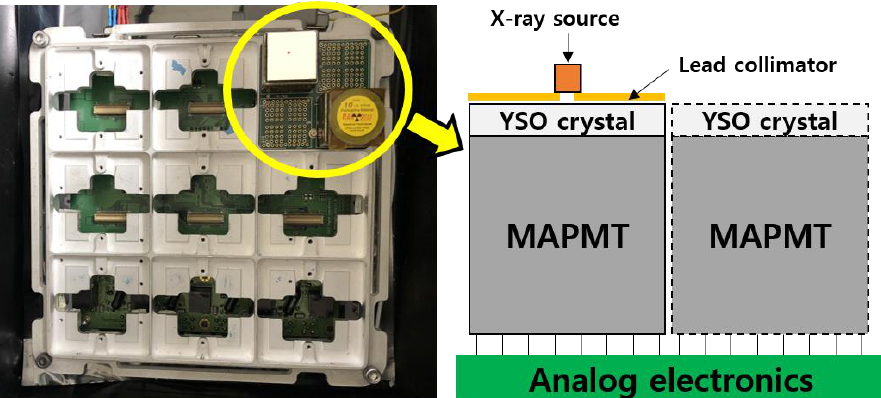
Figure 4. Setup for X-ray energy measurement. The top-right corner of the left-hand figure shows a radioactive source (circle) placed on top of one of two YSO scintillation crystals (silver), the MAPMTs, and an analog board below. The right-hand figure is a schematic side-view drawing of the setup with a lead collimator between the X-ray source and the YSO scintillation crystal.